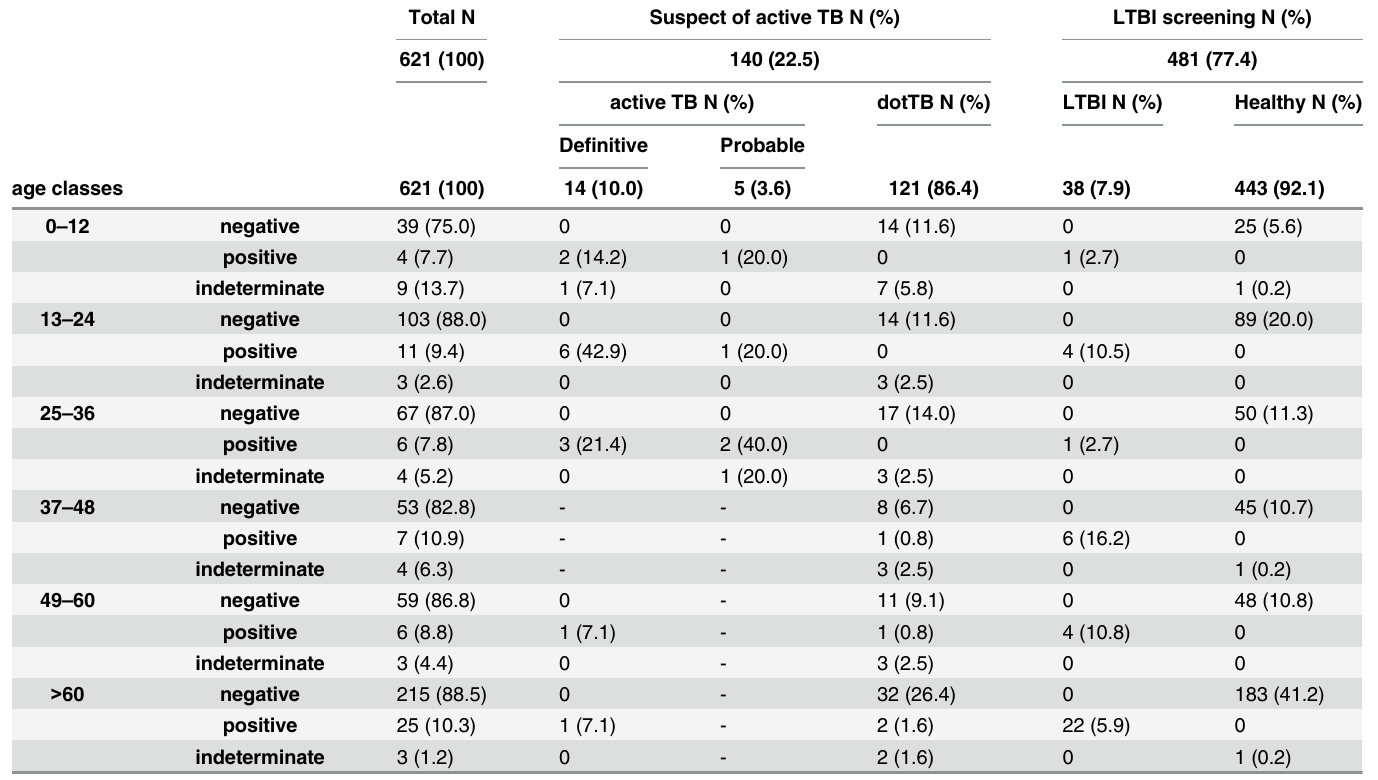
Table 3. QuantiFERON TB Gold in tube (QFT-IT) results as a function of the age.